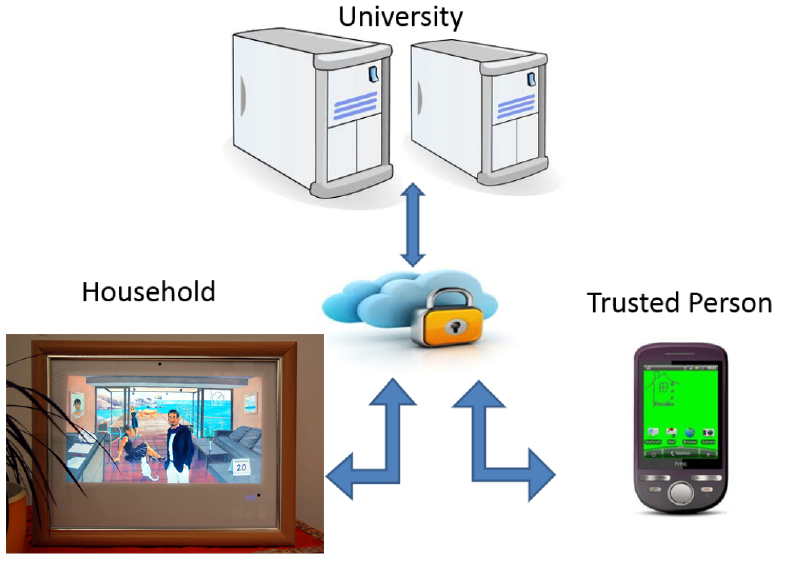
Figure 3. The system architecture showing the servers at the university responsible for backup, data analysis and transfer ( top ), the central unit in the participating household ( bottom left ) and the smart phone of the trusted person ( bottom right